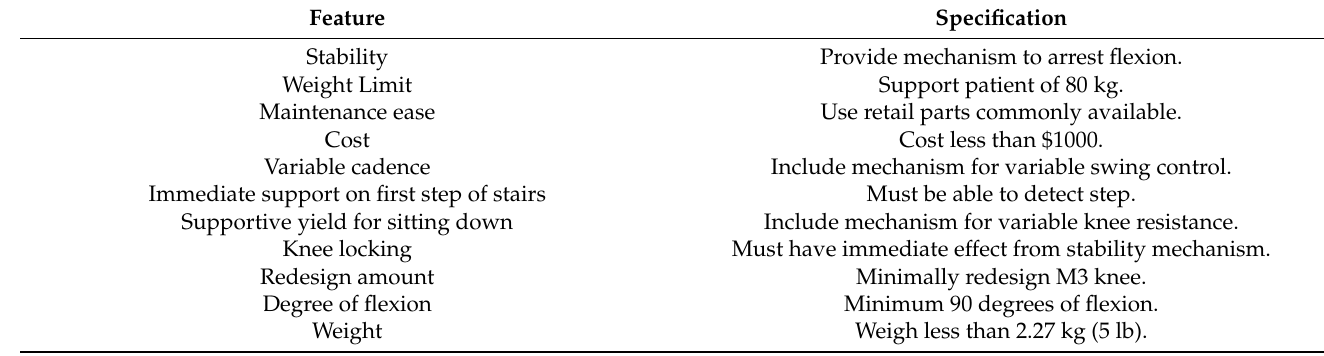
Table 2. Design features based on literature review and field requirements versus prototype de- sign